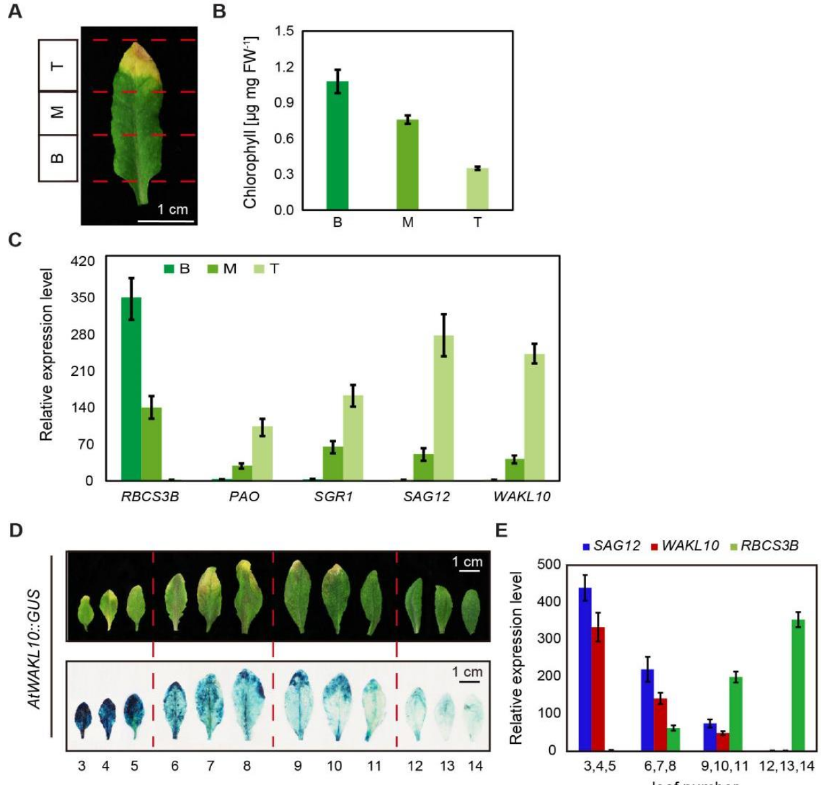
Figure 3. The expression levels of AtWAKL10 in various leaf tissues. ( A ) Representative image of an individual rosette leaf 7 from 8-week-old A. thaliana wild type (Col-0) plants. ( B ) Chlorophyll concentrations, and ( C ) transcript abundance of AtWAKL10 and senescence related marker genes in three leaf sections: T, leaf tip; M, middle part; and B, leaf base. ( D ) GUS staining on rosette leaves from a whole plant of AtWAKL10::GUS transgenic line. The rosette leaves were divided into three groups according to the GUS intensity. ( E ) The transcript levels of AtWAKL10 and two senescence marker genes in each group. The relative expression levels of all tested genes except RBCS3B were calculated relative to the least senescent section (leaf base) or group (leaves 12, 13 and 14). RBCS3B was calculated in an opposite way. Data were given as averages ± SE of three biological